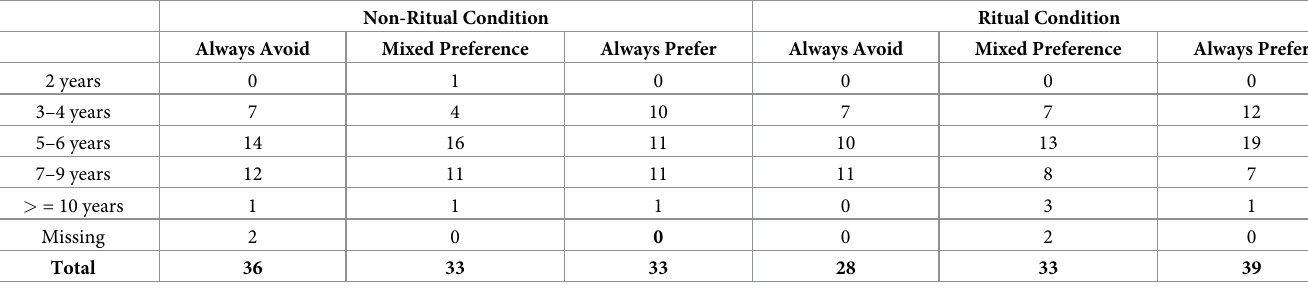
Table 3. Behavior across both trials by condition and